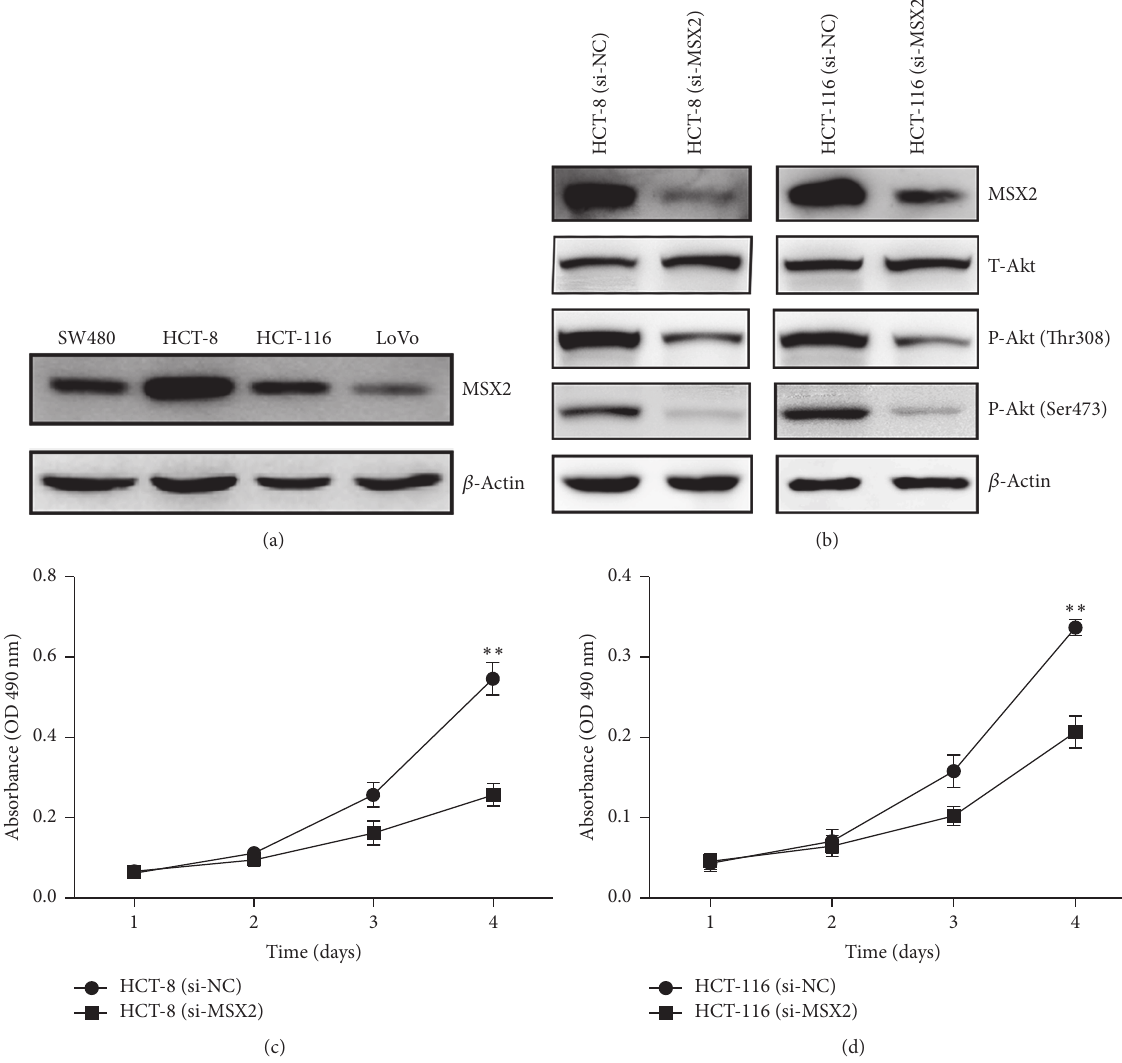
Figure3:KnockdownofMSX2expressionsuppressedproliferationoftheCRCcelllines.(a)TheexpressionofMSX2wasanalyzedbywestern blotting in different CRC cell lines (SW480, HCT-8, HCT-116, and LoVo) and 𝛽 -actin was used as a loading control. (b) Expression of MSX2, T-Akt, and P-Akt in HCT-116 and HCT-8 transfected with si-NC or si-MSX2 was detected by western blotting and 𝛽 -actin was used as a loading control. MTT assay was used to analyze the proliferation of CRC cells transfected with si-NC or si-MSX2 in HCT-116 (c) and HCT-8 cells (d) ( ∗∗ 𝑃 < 0.01 ). Data show the mean ± SD of five independent experiments at each time